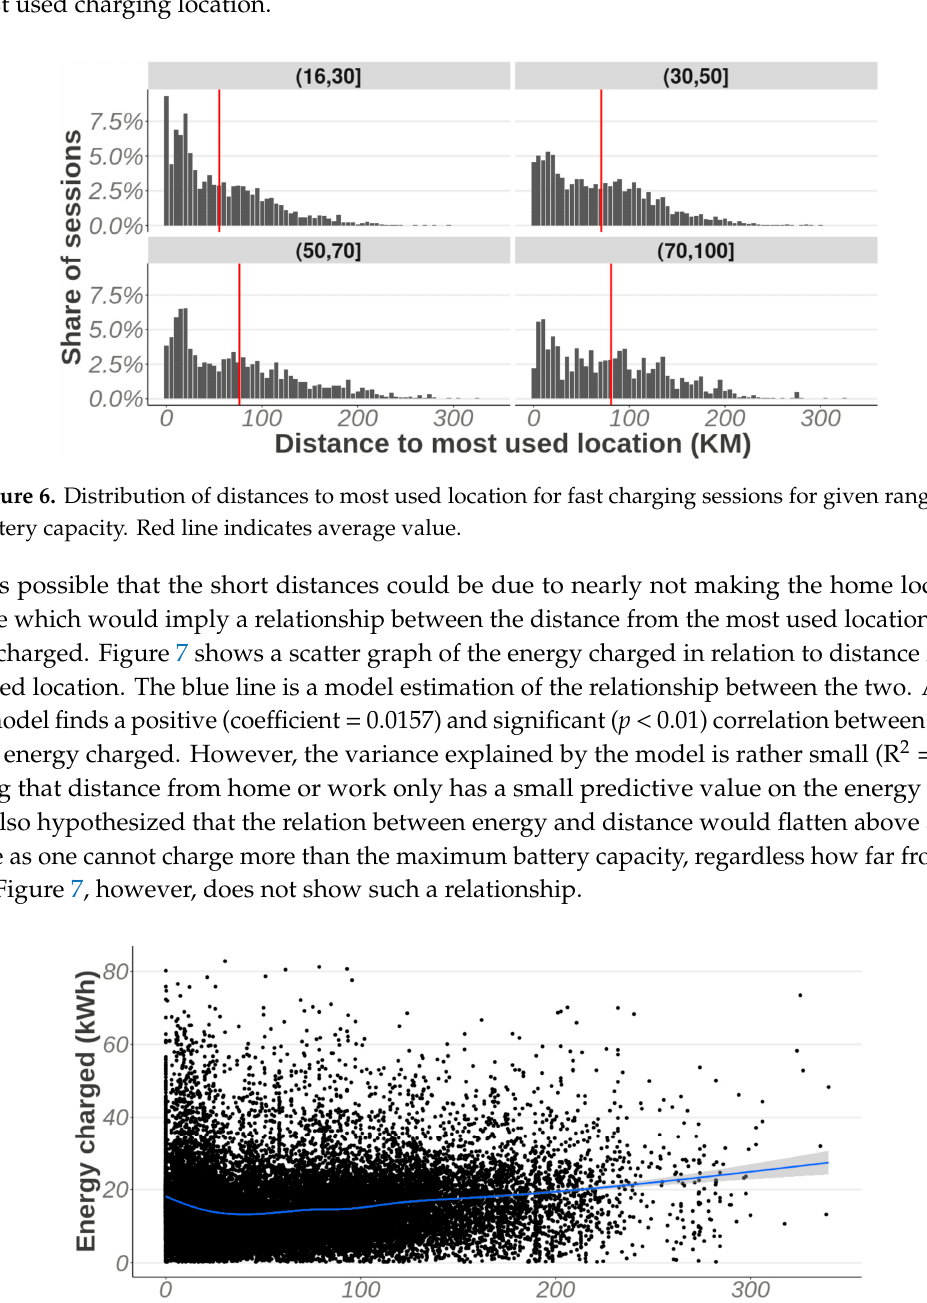
Figure 7. Scatterplot with regression line (blue) of energy charged at fast charging stations in relation to distance to most used charging location.